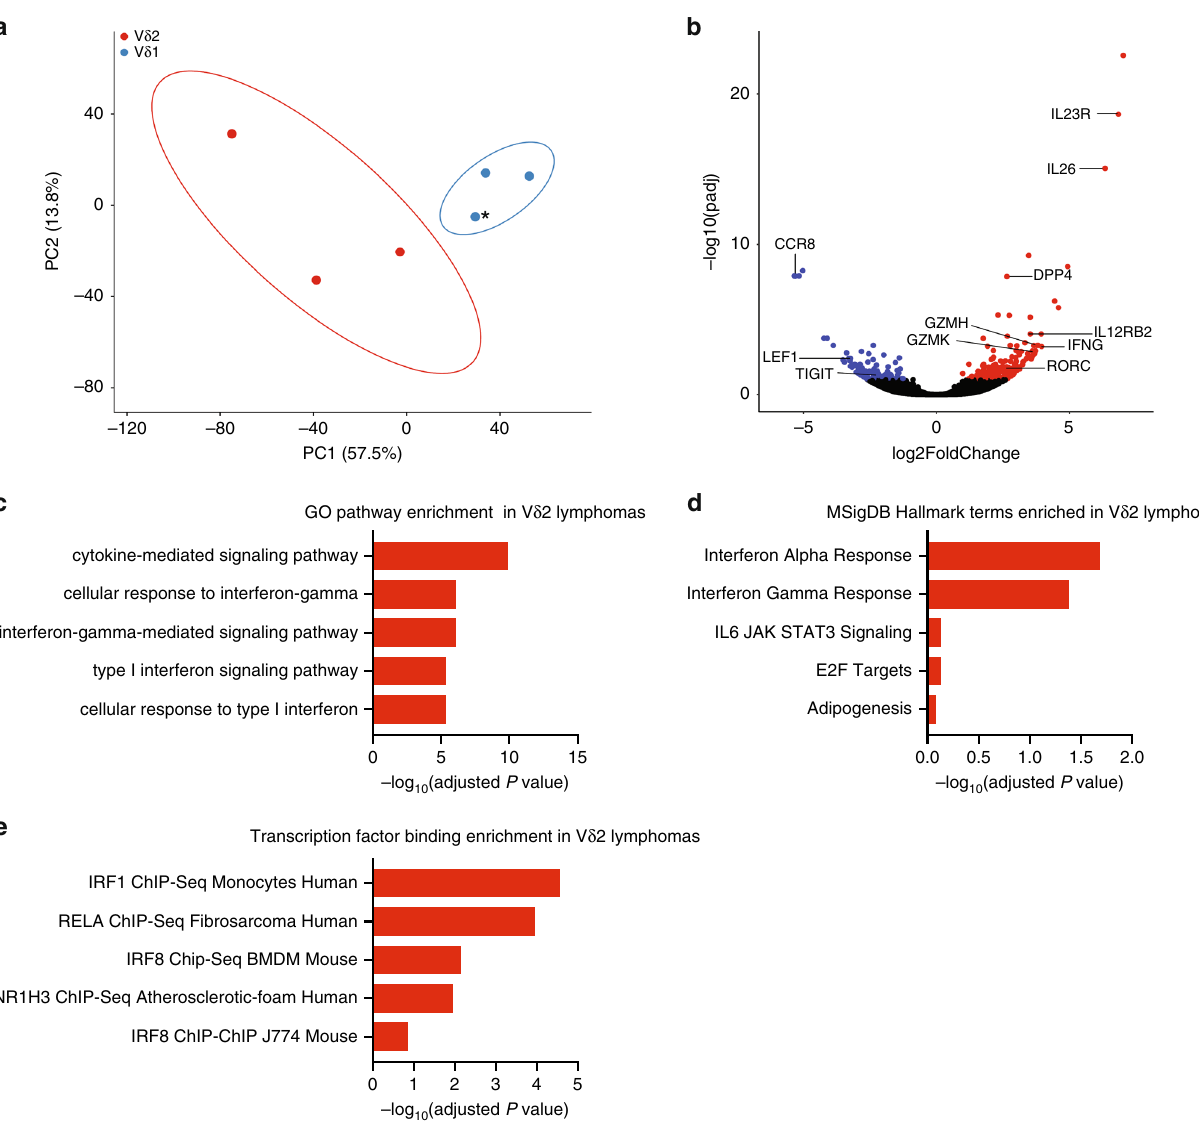
Fig. 2 V δ 1 and V δ 2 CGDTL lymphomas are transcriptionally distinct. a Principal component analysis of transcriptomes of V δ 1 and V δ 2 PCGDTL samples. * Indicates V δ 1 γδ MF with PCGDTL-like progression sample. b Volcano plot of differentially expressed genes signi fi cantly upregulated in V δ 1 (blue) and V δ 2 (red) with an adjusted P value < 0.05 (DESeq2). Select immune-related genes are labeled. c – e Top fi ve pathways upregulated in V δ 2 PCGDTL lymphomas via GO pathway, MSigDB Hallmark, and CheA transcription factor-binding analysis